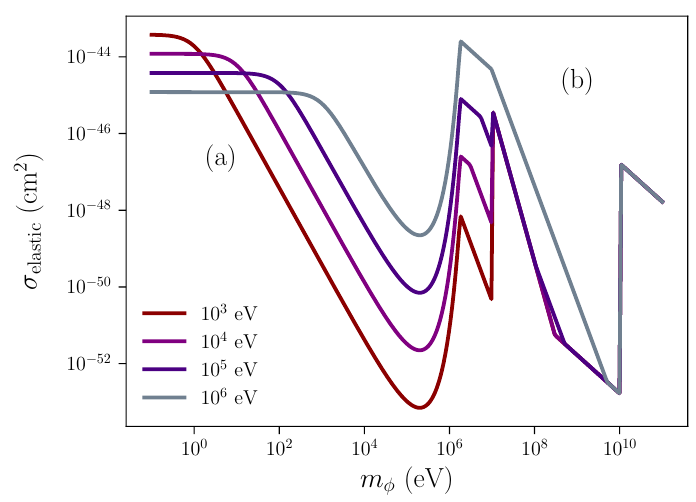
Figure 2 . Limits on the dark matter-electron elastic cross-section as a function of mediator mass for various dark matter masses in the range keV{MeV, as indicated in the legend. The region (a) is primarily constrained by white dwarf cooling while region (b) is limited by B-factory searches and cosmology. The sharp feature at m (cid:30) 10 5 (cid:0) 6 eV arises when m (cid:30) approaches the white dwarf fermi- (cid:24) momentum, k f 400 keV and the additional cooling rate falls exponentially. A second feature at (cid:25) m (cid:30) 10 MeV indicates where thermalization of the mediator becomes possible because it can decay (cid:25) to electrons or neutrinos before neutrino decoupling. Neutrino decoupling is a gradual process that begins around 10 MeV and therefore the precise localization of this feature requires more